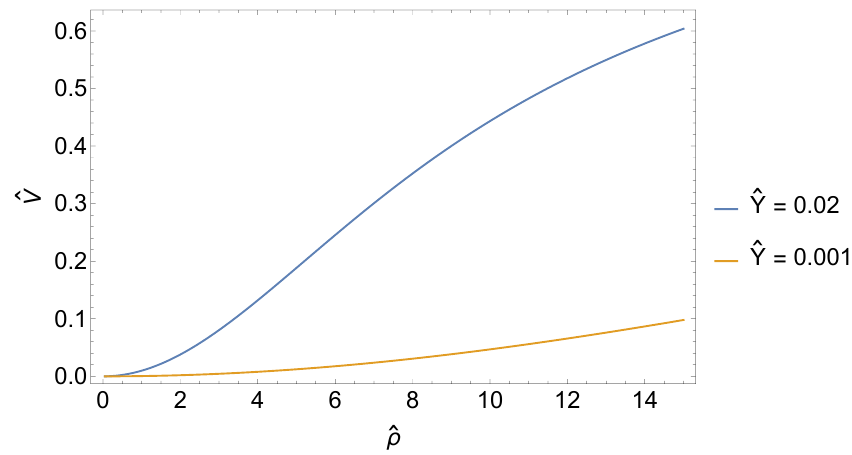
Figure 2 . Scalar potential ^ V for the canonical (cid:12)eld ^ (cid:26) for two di(cid:11)erent values of